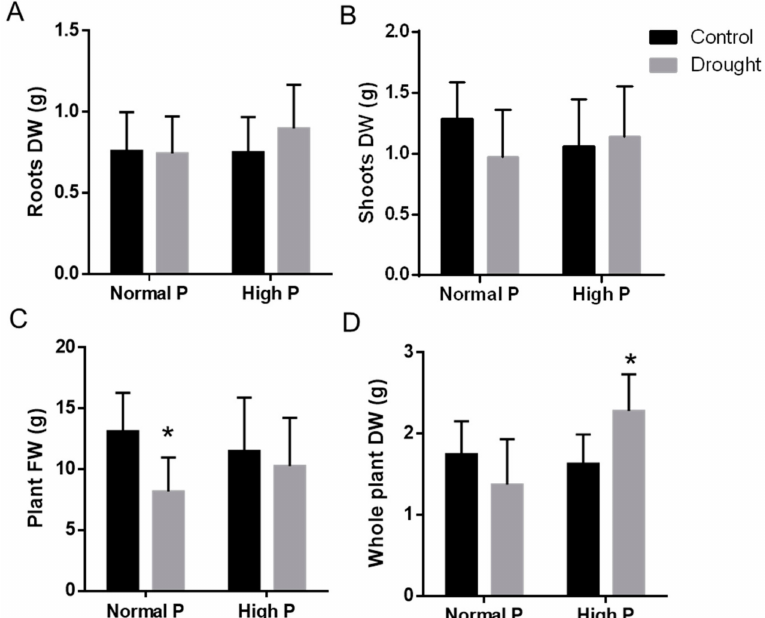
Figure 7. E ff ects of 10 days-water-deficit in the biomass of P. vulgaris plants that were well-watered (control) or drought-stressed (drought) cultivated with 82 µ M KH 2 PO 4 (Normal P) or irrigated with 200 µ M of KH 2 PO 4 (High P) before the drought treatment. ( A ) Biomass of roots after removal of nodules, ( B ) shoots biomass, ( C ) whole plant fresh weight, and ( D ) whole plant biomass of well-watered (control) and 10 days-drought-stressed (drought) plants. Data are means of three independent experiments with 10 plants from each treatment. Asterisks indicate statistical di ff erences (p < 0.05